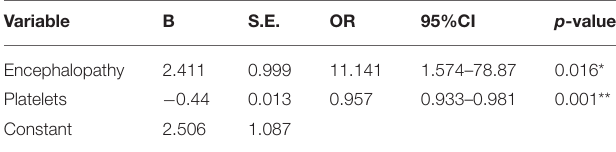
TABLE 10 | Analysis of independent risk factors for fetal mortality. Variable B S.E. OR 95%CI p -value